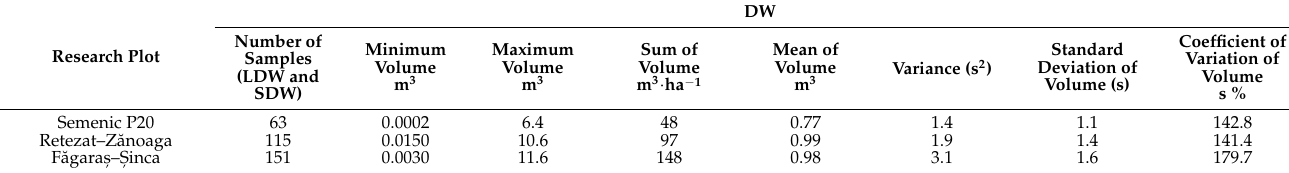
Table 3. Descriptive statistics of dead wood volume